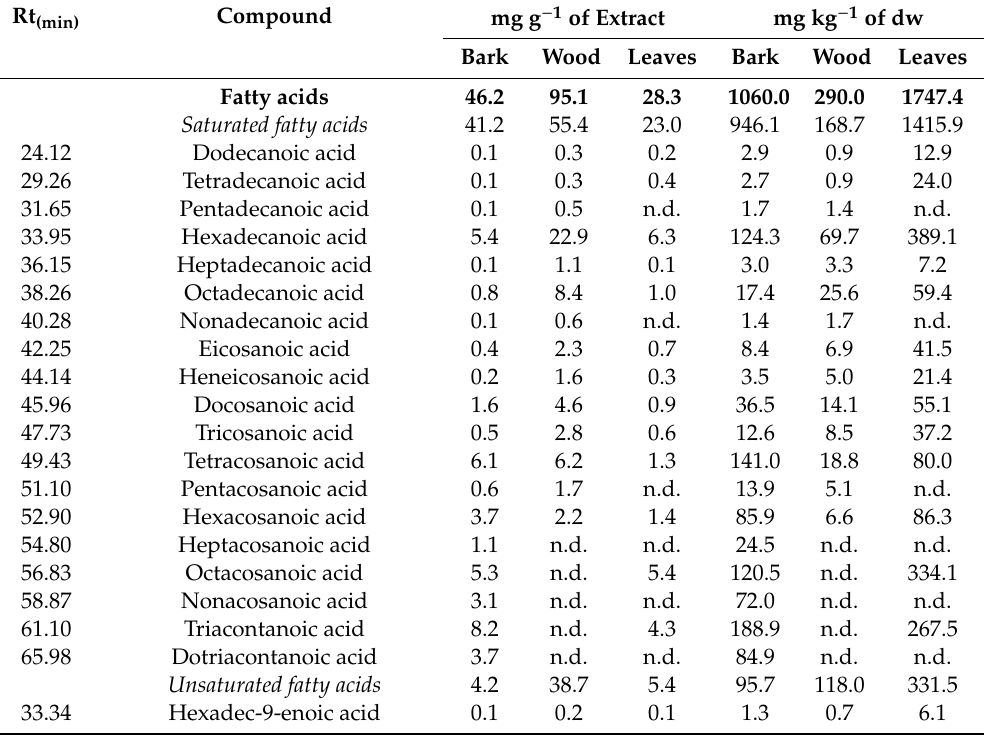
Table 1. Chemical composition of dichloromethane extracts from bark, wood and leaves lipophilic of A. dealbata. Rt (min) Compound